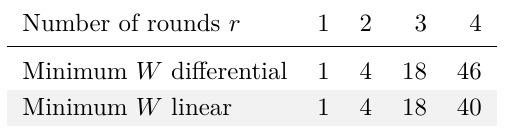
Table 5: Minimum weight in number of active cells for